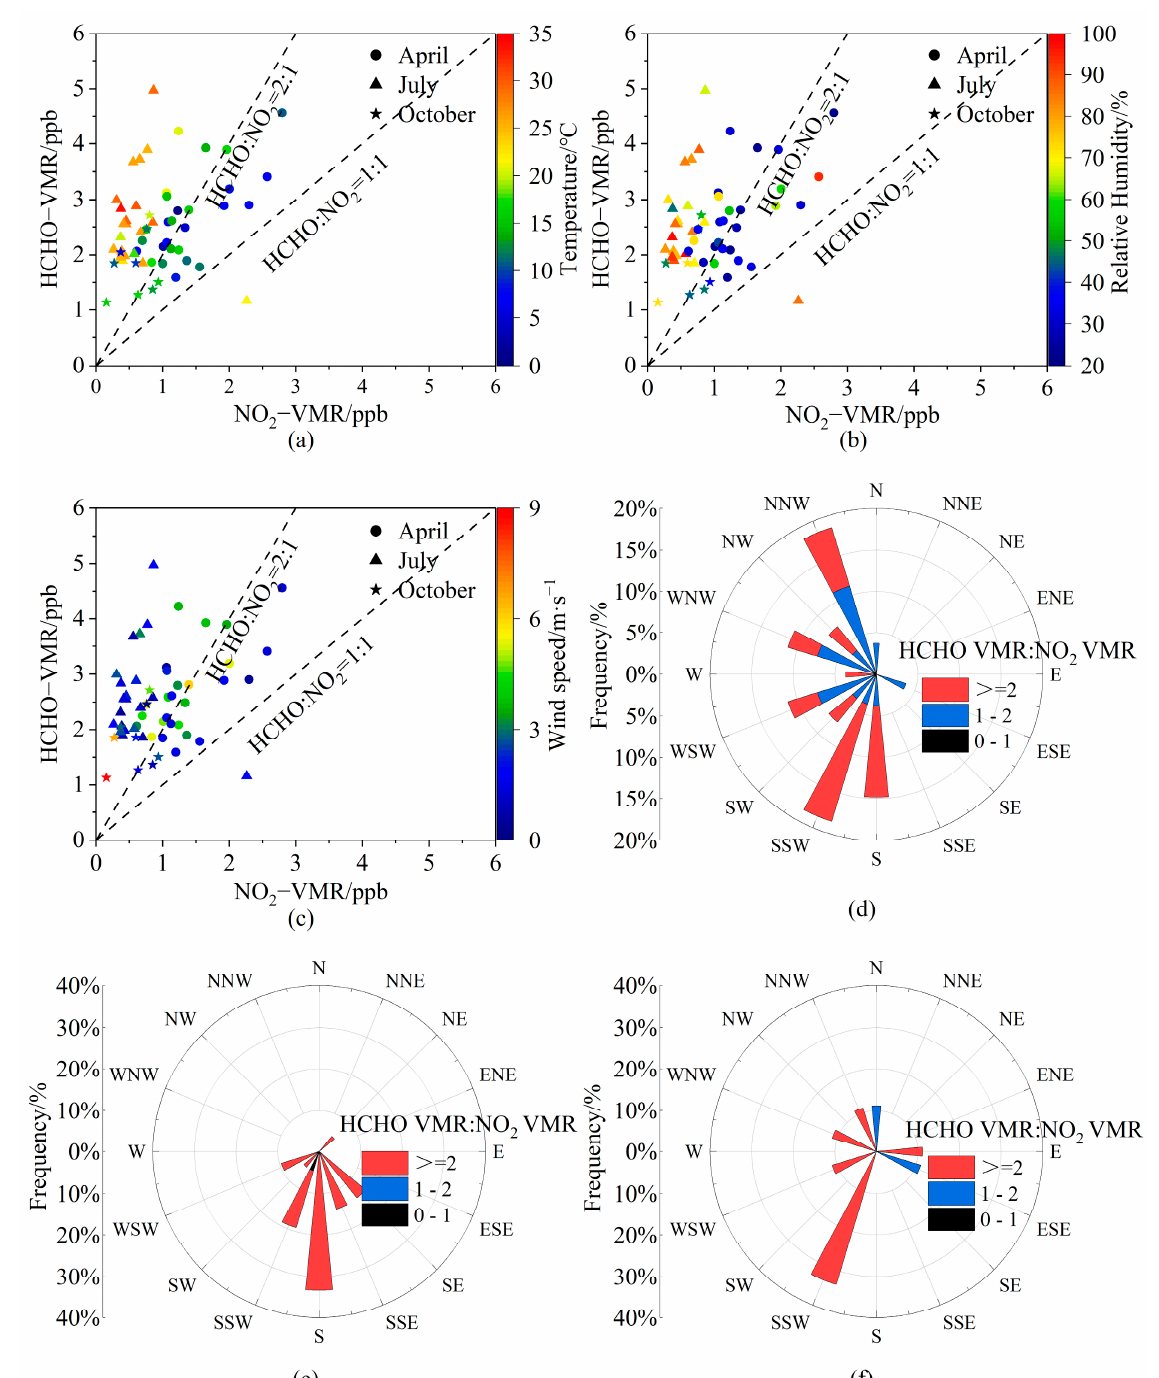
Figure 12. Relationship between the near-surface VMR ratios of HCHO to NO 2 and meteorological factors, i.e., ( a ) air temperature, ( b ) relative humidity, ( c ) wind speed, and ( d − f ) wind direction. The dots, triangles, and pentagrams represent April, July, and October 2021, respectively. Rose plots denote RA VMR frequencies in 16 wind directions in ( d ) April, ( e ) July and ( f ) October 2021.